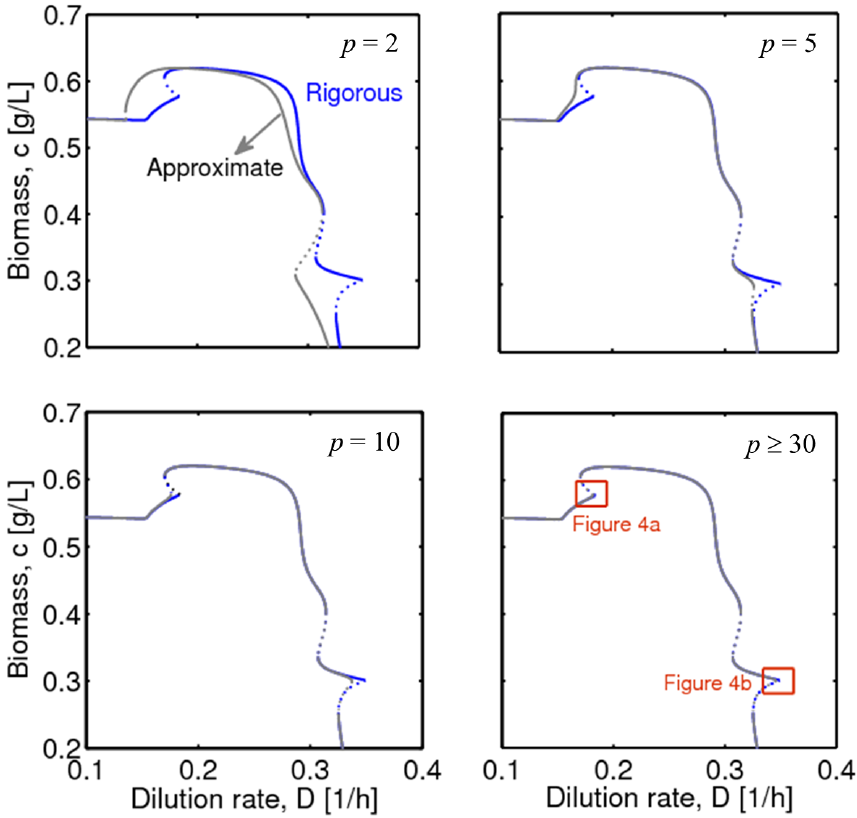
Figure 3. Reproduction of the hysteresis curve of Figure 2a using the L approximation with different p